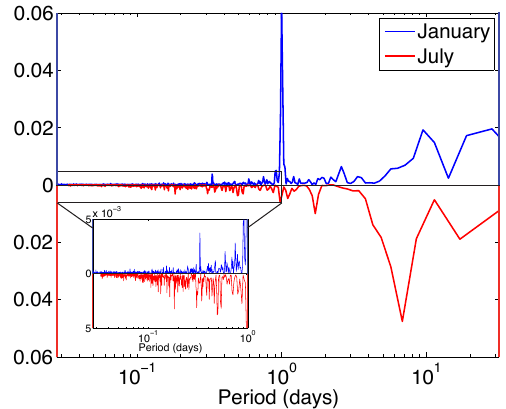
Fig. 5. Power spectrum of January 2012 (blue) and July 2012 (red) CH 4 mole fractions normalized by the total of each month. July is shown as a mirror for